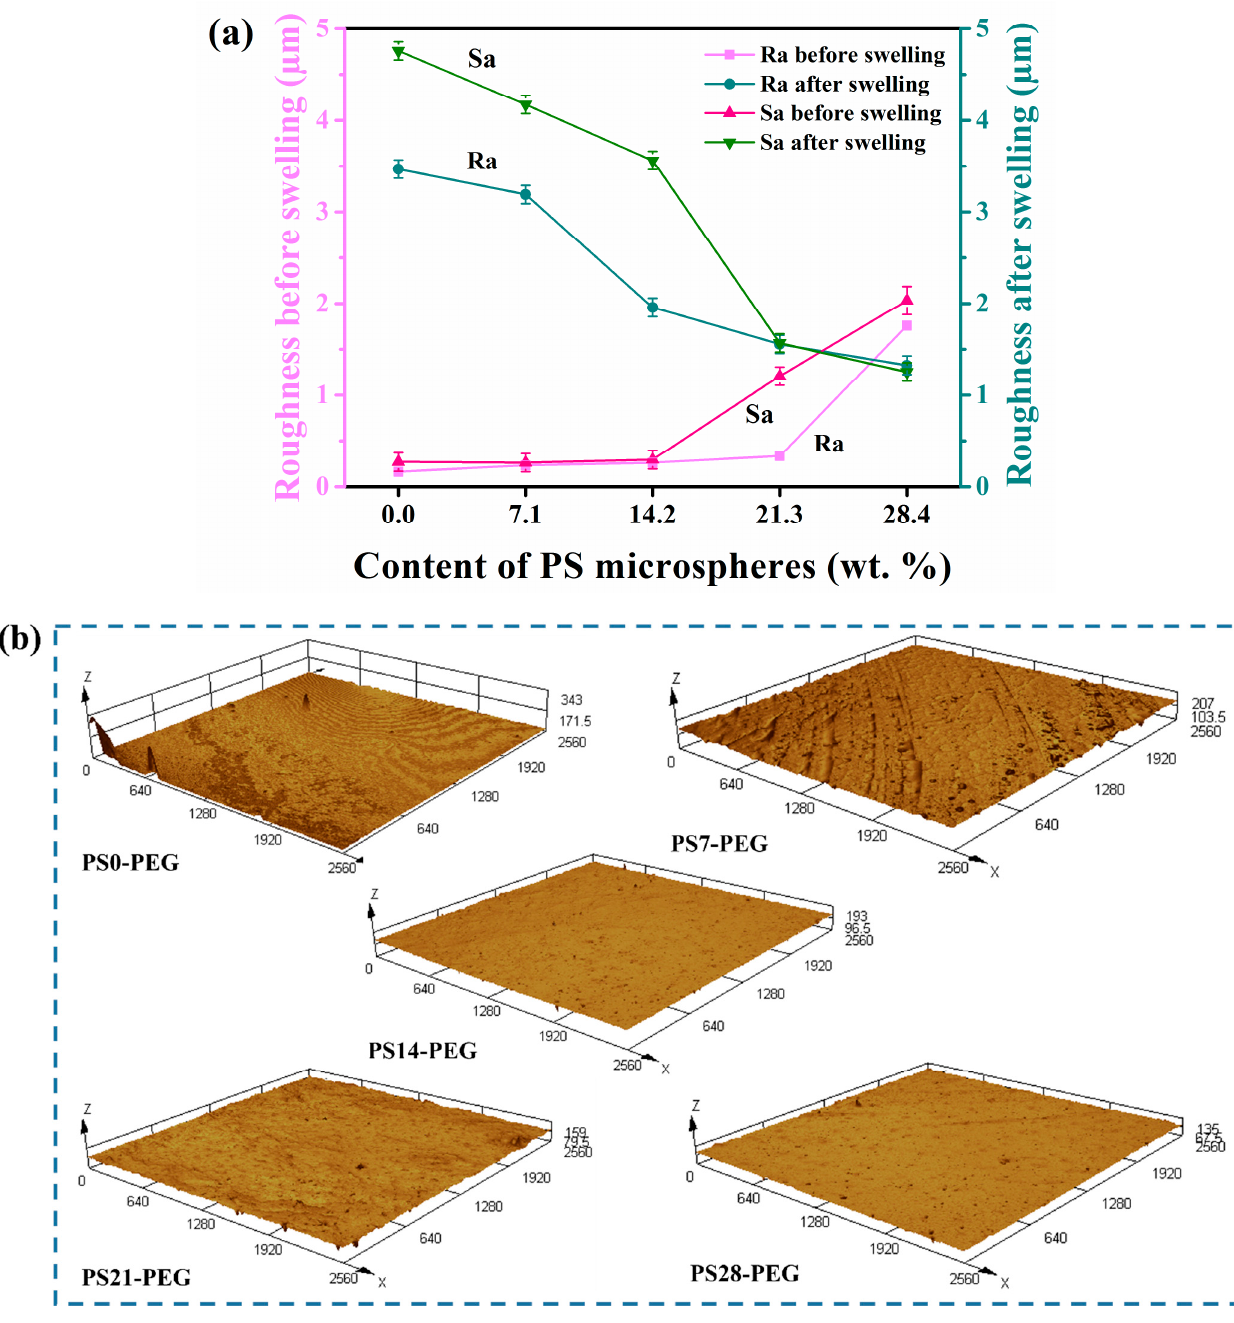
Figure 7. Surface roughness and 3D morphology of the samples: ( a ) Roughness of XH and SSH samples, ( b ) 3D surface morphology of the SSH samples.